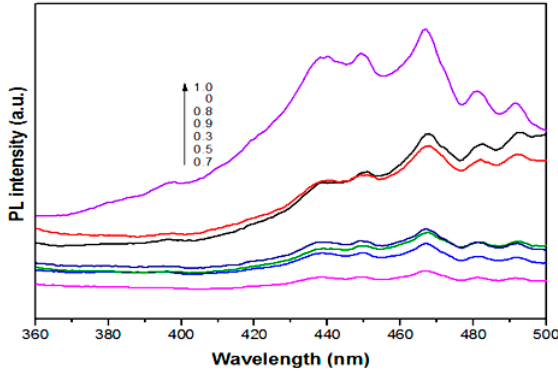
Figure 5. Photoluminescence emission spectra of different samples with excitation at 320 nm.